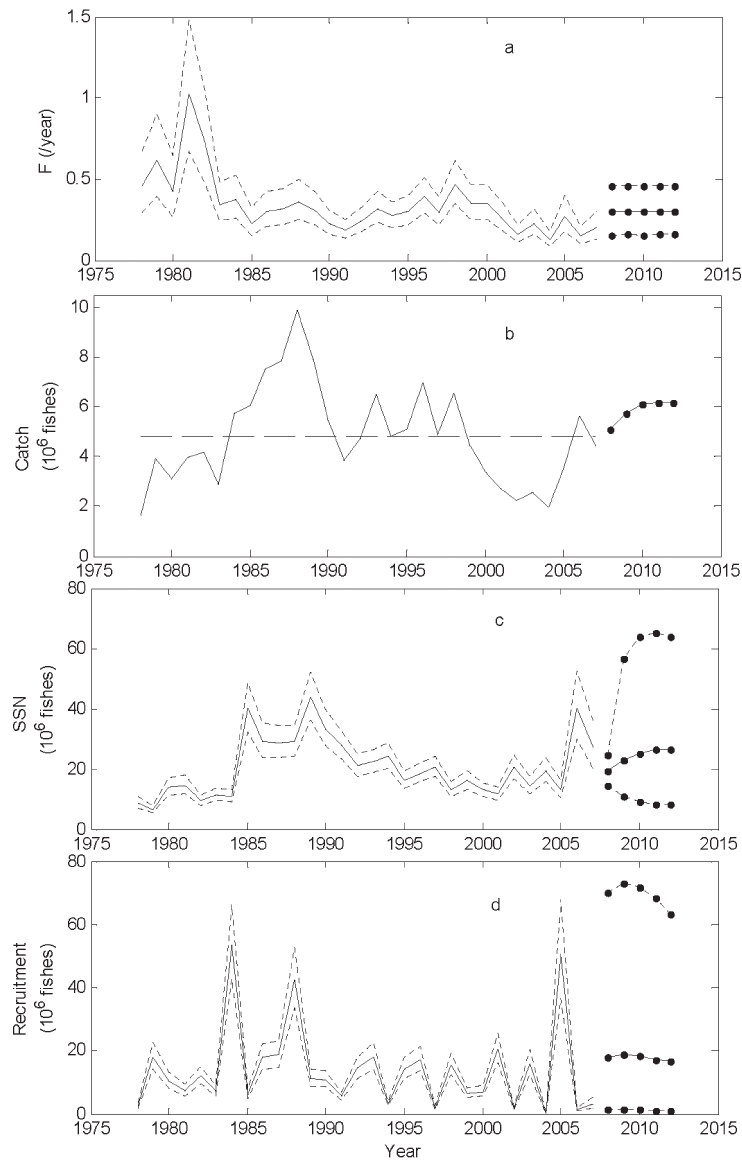
Fig . 7. – Projections of the fishing mortality, population size and catch based on the method shown in Figure 3 (also see the methods section). a): solid line: estimated fishing mortality based on data from 1978 to 2007; dotted lines: posterior 95% credible interval of fishing mortality; solid line with marker: projected mean fishing mortality for management; dotted lines with marker: 95% confidence interval of the projected fishing mortality. b): solid line: observed catch from 1978 to 2007; dashed line: mean catch among 1978 to 2007; solid line with marker: projected total allowable catch that matches the example management objective. c): solid line: estimated spawning stock size (SSN) based on data from 1978 to 2007; dotted lines: posterior 95% credible interval of SSN; solid line with marker: projected mean SSN; dotted lines with marker: 95% confidence interval of the projected SSN. d): solid line: estimated recruitment based on data from 1978 to 2007; dotted lines: posterior 95% credible interval of recruitment; solid line with marker: projected mean recruitment; dotted lines with marker: 95% confidence interval of the projected